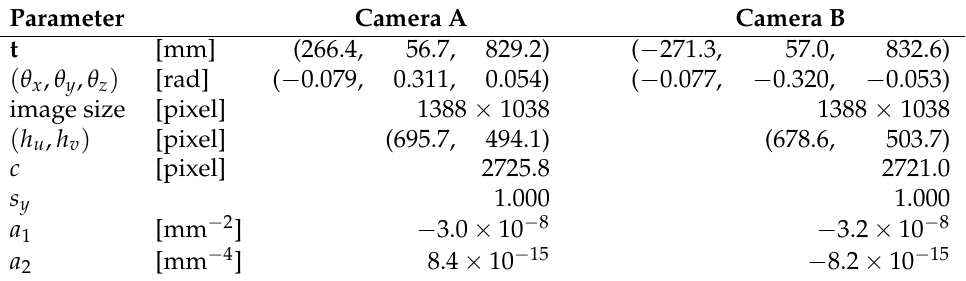
Table 1. Camera parameters of the calibrated sensor